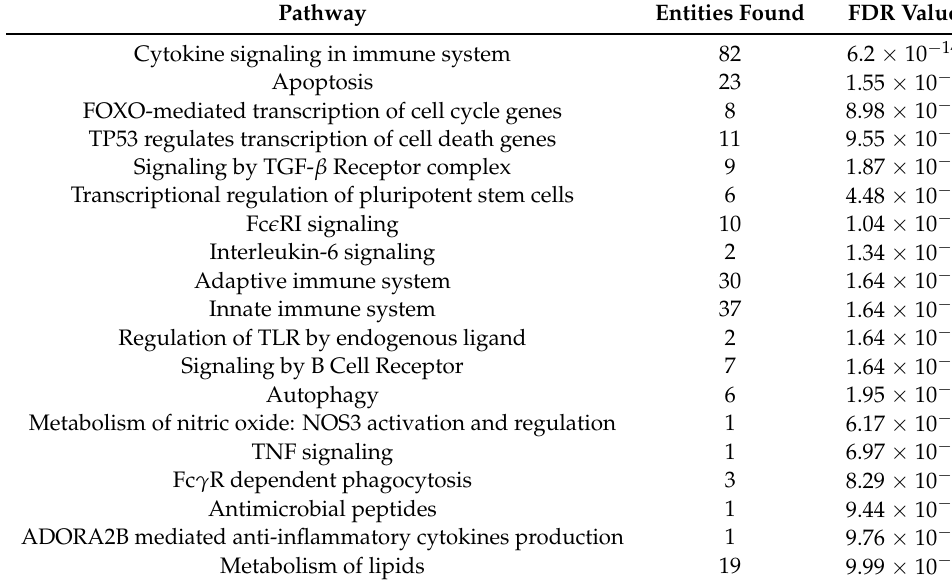
Table 1. Gene set enrichment analysis results for genes associated with upregulated miRNAs (Medical Samples vs. External Control